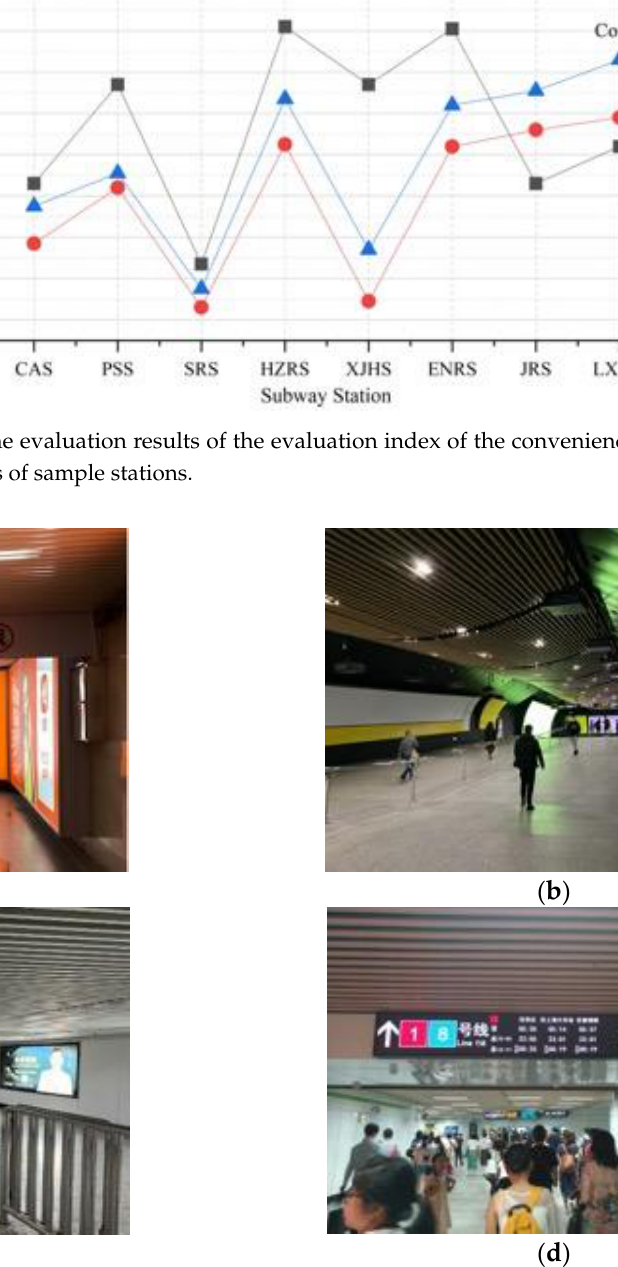
Figure 11. Sample station transfer space environment convenience status problem: ( a ) Identifica- tion information severely obscured; ( b ) passageway too wide; ( c ) passageway too low; ( d ) two- way mixed traffic. Images courtesy of the author.